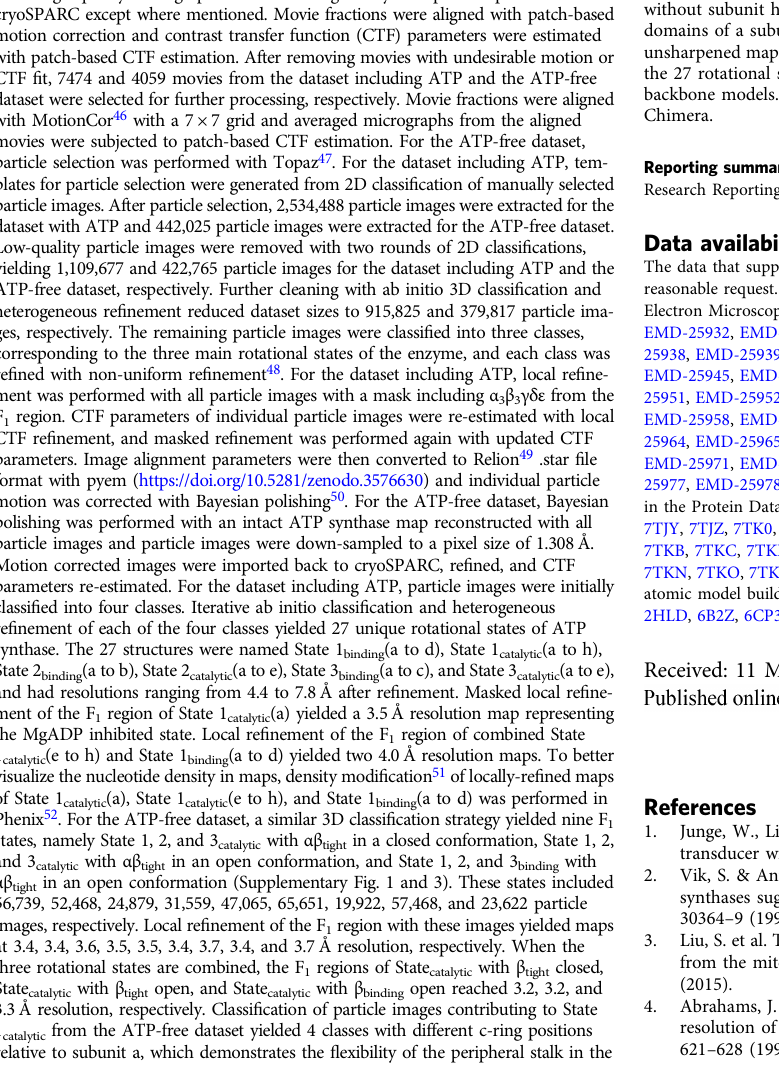
Fig. 4 Sequence of conformations in the ATP hydrolysis and ATP synthesis cycles. a The unstrained conformation of State 1 catalytic shows density consistent with MgADP in the αβ tight catalytic pair (left, yellow), suggesting an ADP-inhibited state, while the strained conformations show density consistent with MgATP (right, purple) suggesting an active state. b Measurement of the rotation of the rotor subunit γ within the F 1 region shows 36° and 84° sub-steps between catalytic and binding dwell conformations. c Measurement of the rotation of the c-ring relative to subunit a in F O . Within each binding or catalytic dwell conformation the peripheral stalk becomes increasingly strained as the c-ring rotates in the ATP synthesis direction and increasingly relaxed as the c-ring rotates in the ATP hydrolysis direction. Transition between catalytic and binding dwell conformations would require back- stepping of the c-ring (shaded areas) if every conformation occurred during the rotary cycle. Colors in ( b ) and ( c ) are de fi ned as in